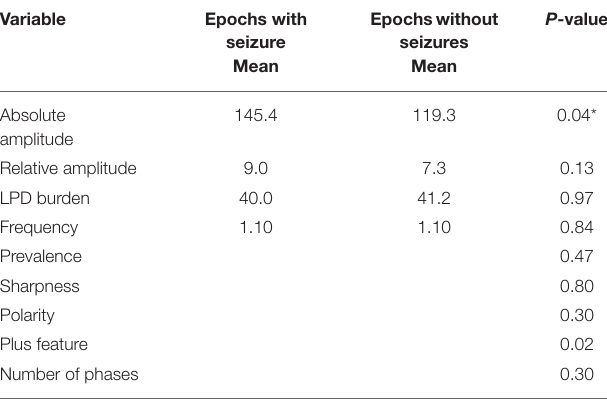
TABLE 2 | Patient characteristics. Characteristics